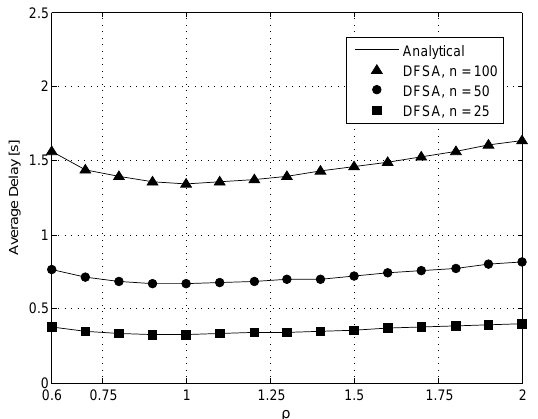
Figure 6. DFSA average delay (seconds) depending on ρ